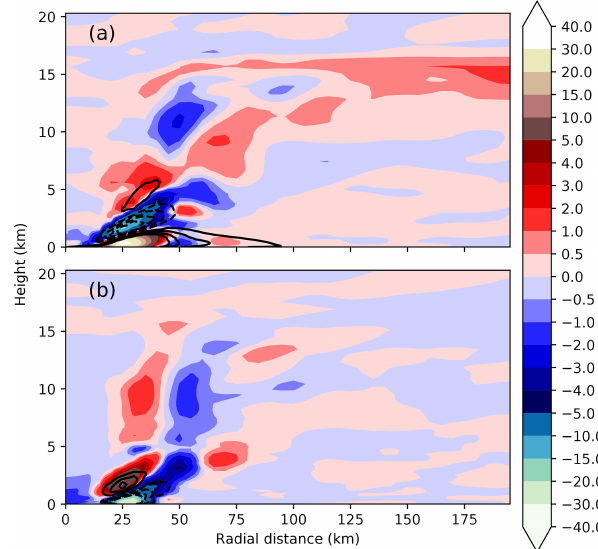
Figure 18. Absolute angular momentum budget composites show- ing (a) mean advection of angular momentum and (b) eddy advec- tion of angular momentum . Colour shading shows the difference in tangential wind tendency between the strengthening phase compos- ite and the weakening phase composite in ms − 1 h − 1 . Line contours (5ms − 1 h − 1 intervals, dashed lines imply negative values) show a composite of the contribution to tangential wind budget during all the strengthening phases (for example in subplot a at around 50km there is a strongly positive tangential wind tendency from the mean term over all the strengthening